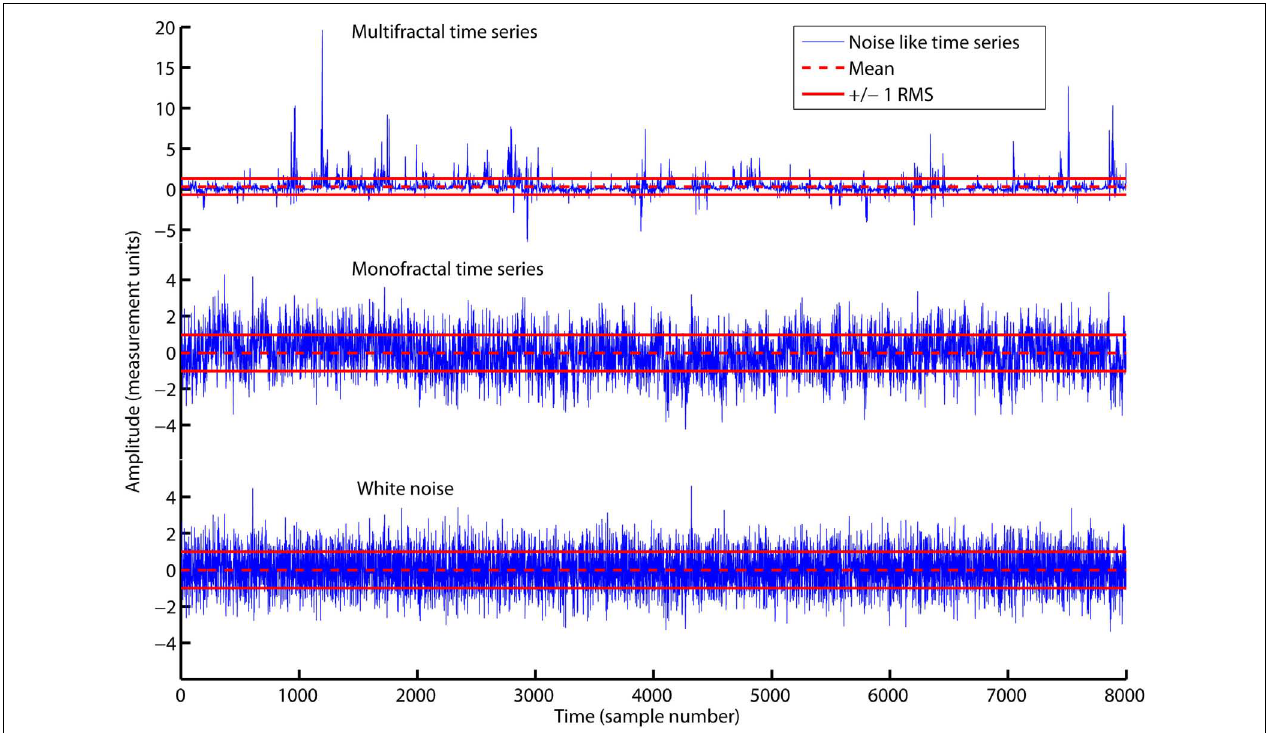
RMS = 1, but quite different structure. RMS is only sensitive to differences in the amplitude of variation and not differences in the structure of variation. Notice the different scaling for the vertical axis of the multifractal time